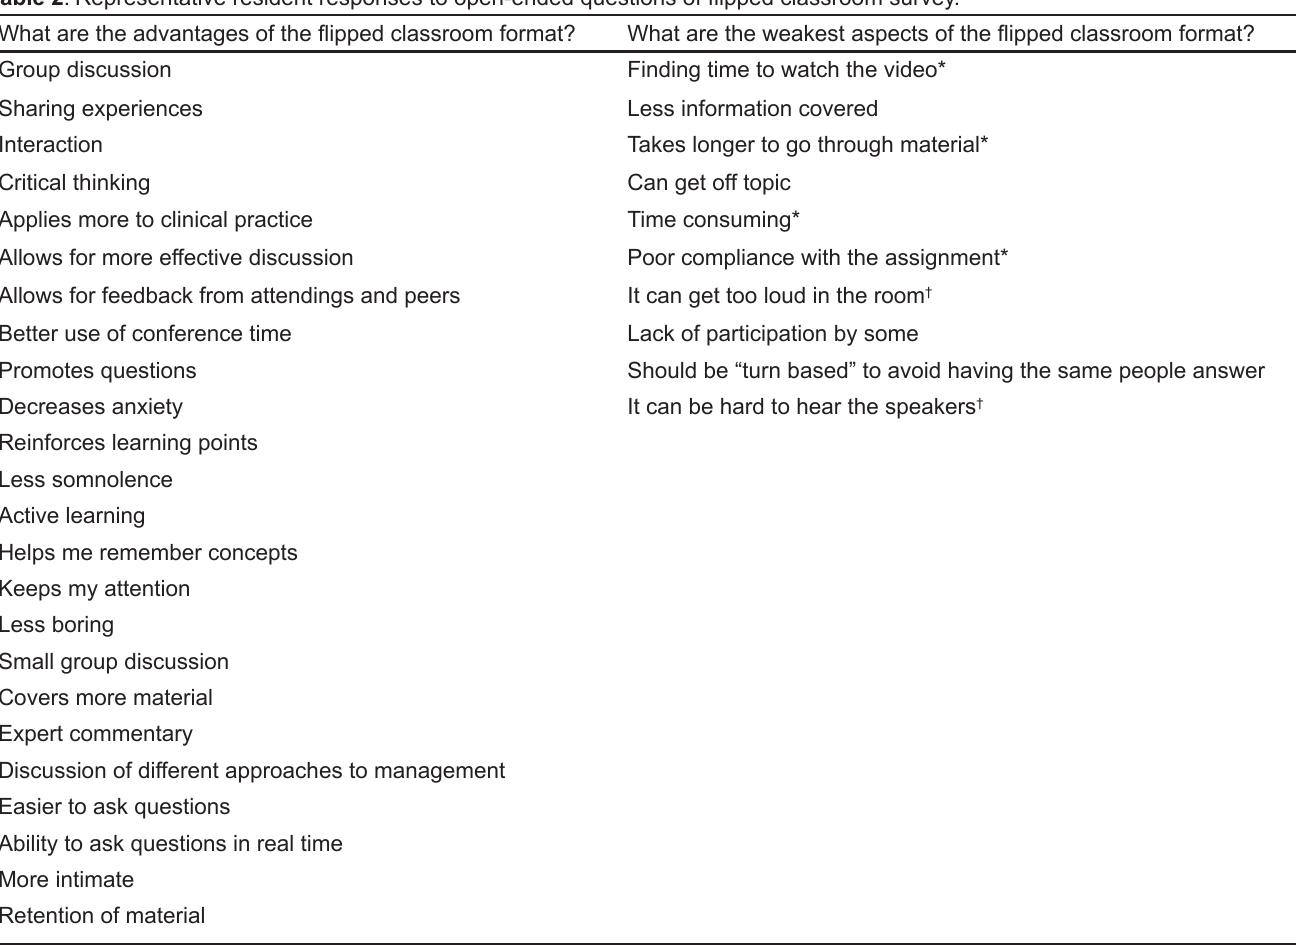
Table 2 . Representative resident responses to open-ended questions of flipped classroom survey.